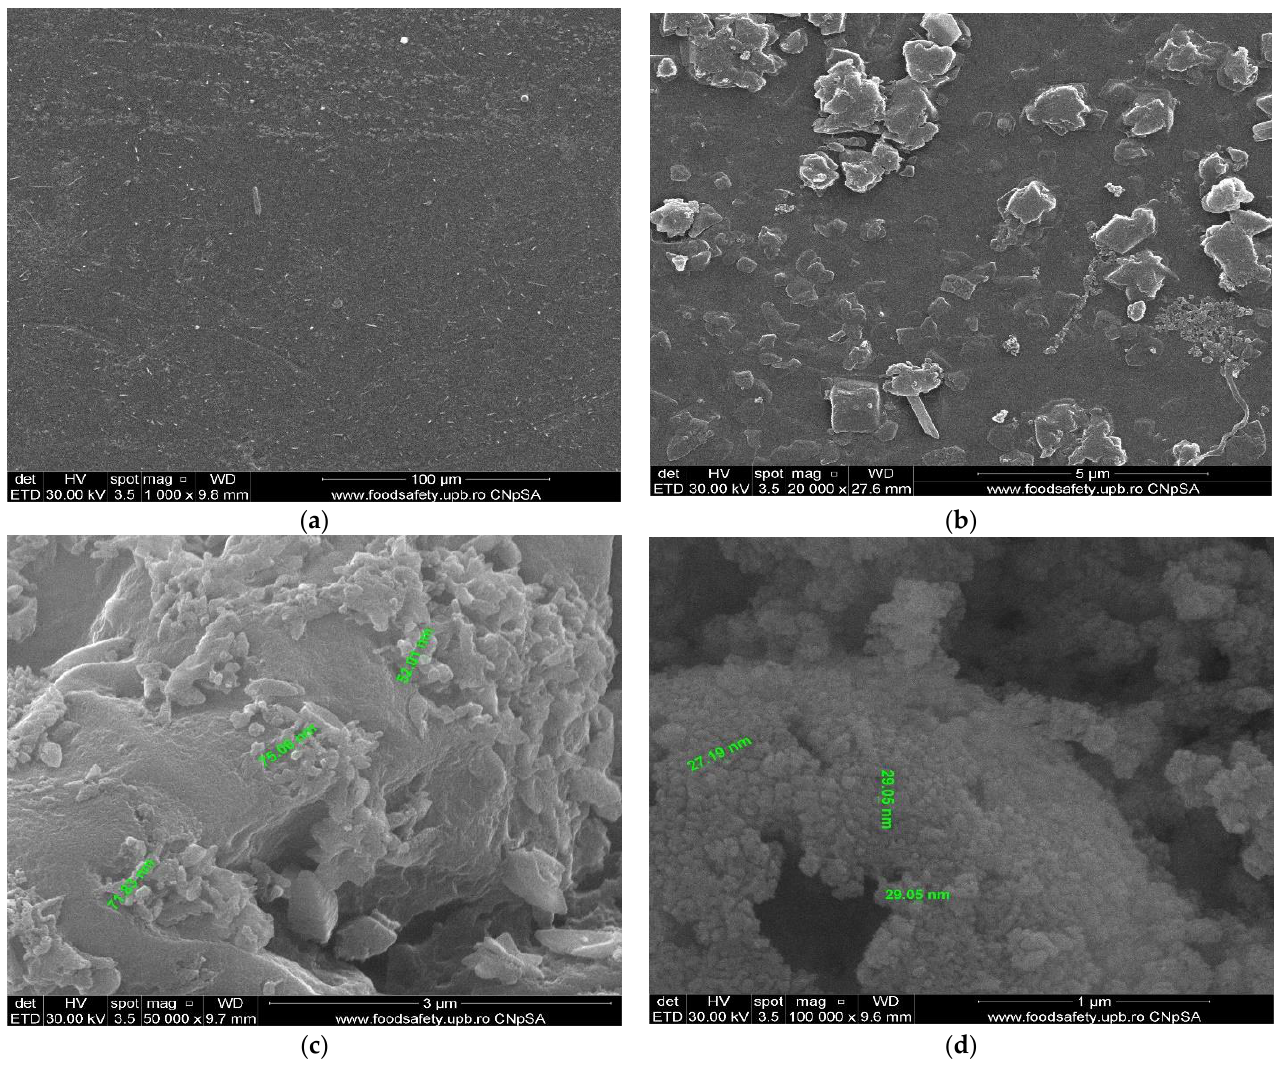
Figure 9. The scanning electron microscopy of the osmium – polysulfone membranes (Os – PSf): membrane surface ( a , b ); cross section and nanoparticle details ( c , d ).